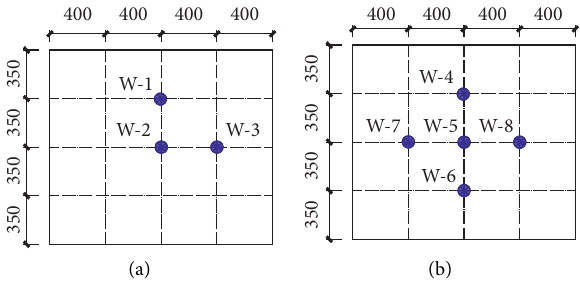
Figure 5: Layout of displacement meter: (a) top of the slab; (b) bottom of the